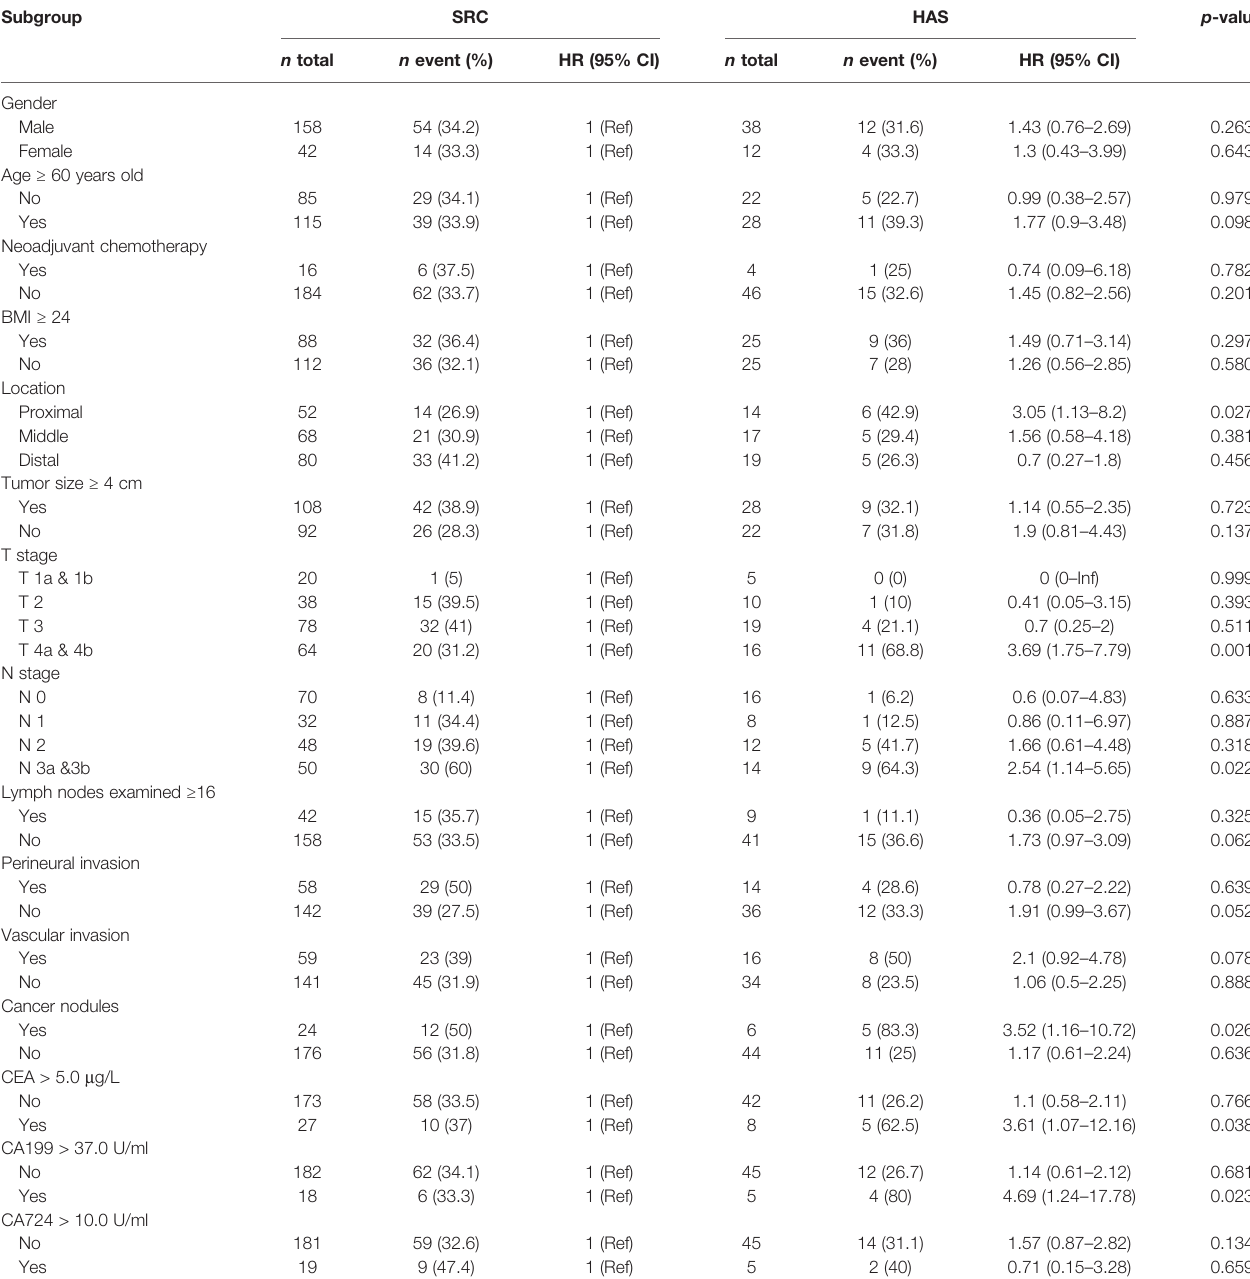
TABLE 3 | Subgroup analysis with univariate Cox regression analysis of overall survival between HAS and SRC after PSM. Subgroup SRC